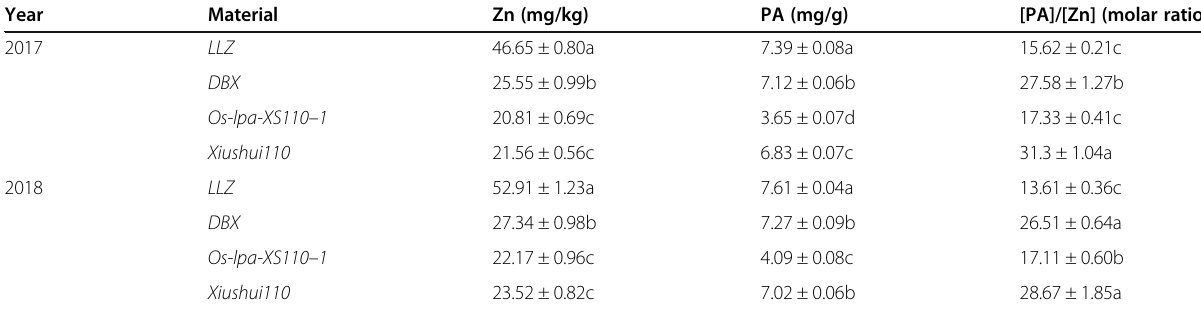
Table 2 Zn, phytic acid and their molar ratio in the brown rice of the mutant lines and their wild type